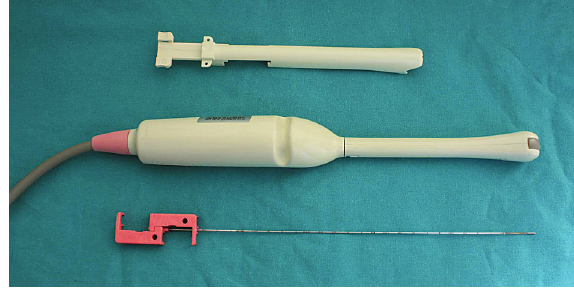
Figure 2 – Reusable needle guide and transrectal